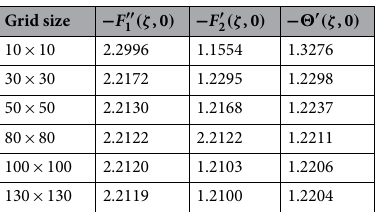
Table 3. Study of different size of grid independent when Ŵ